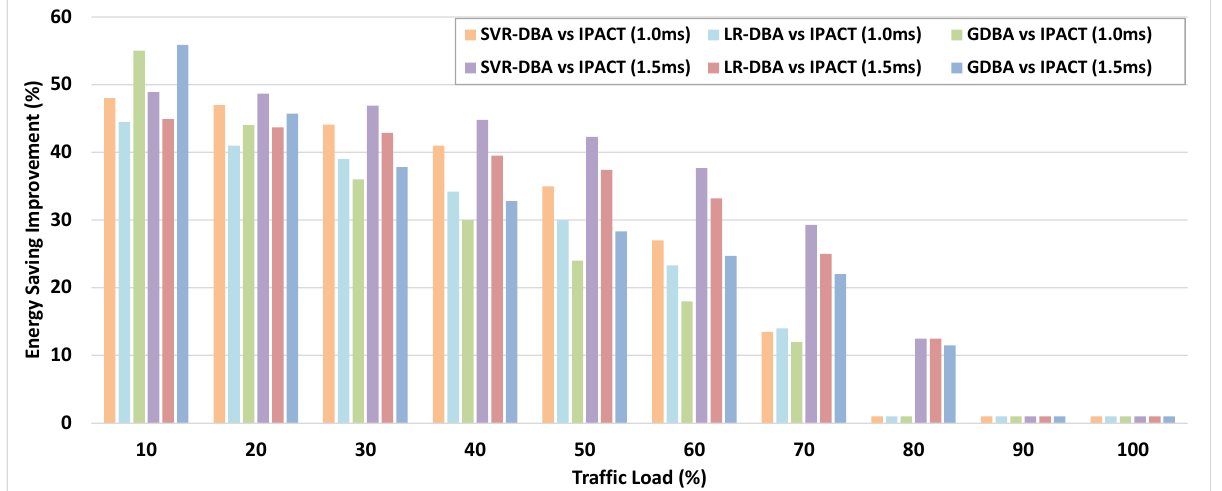
Figure 8. Average energy consumption improvements of SVR-DBA, LR-DBA, and GDBA for 1.0 ms and 1.5 ms cycle times.